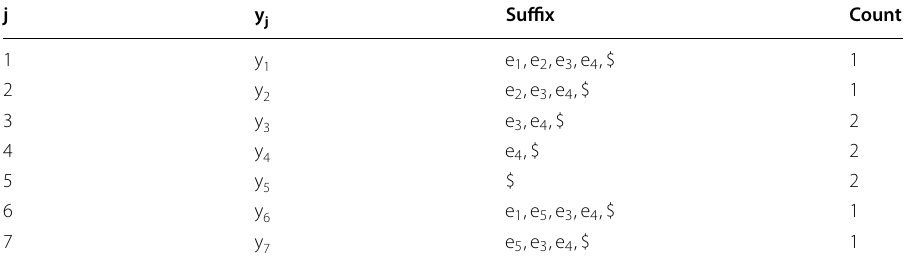
Table 5 All suffix and their frequency count computed by